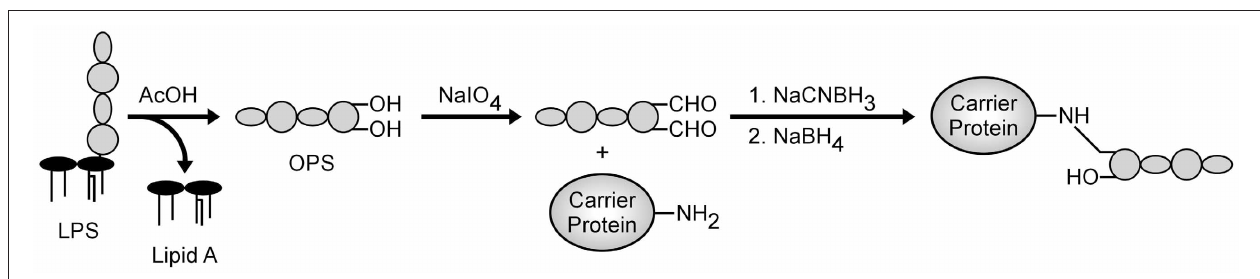
FIGURE 2 | Generalized scheme for the conjugation of chemically activated B. thailandensis OPS to carrier proteins.